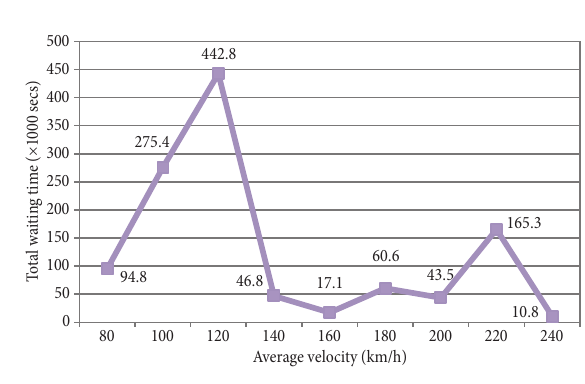
Fig. 3. The capacity–velocity